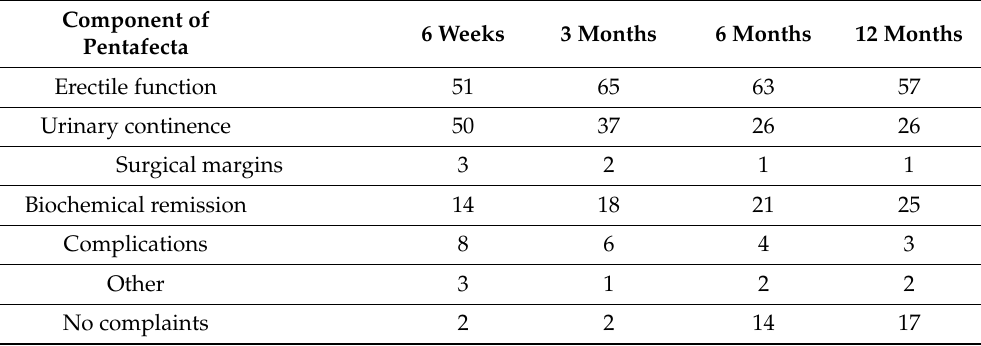
Table 3. List of unfulfilled pentafect components mentioned by the patient as the most inconvenient (cases n = 131).